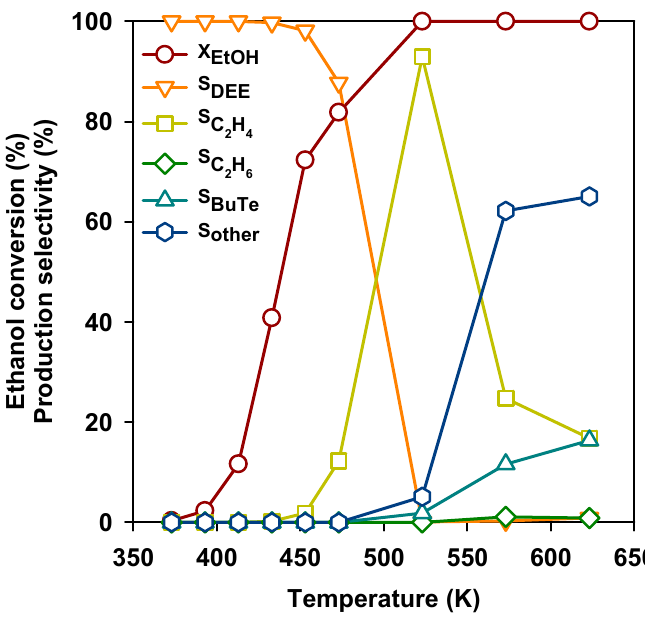
Figure 4. Ethanol conversion and selectivities to the products as a function of temperature over the H-ZSM-5 (Si/Al 2 = 50) zeolite.